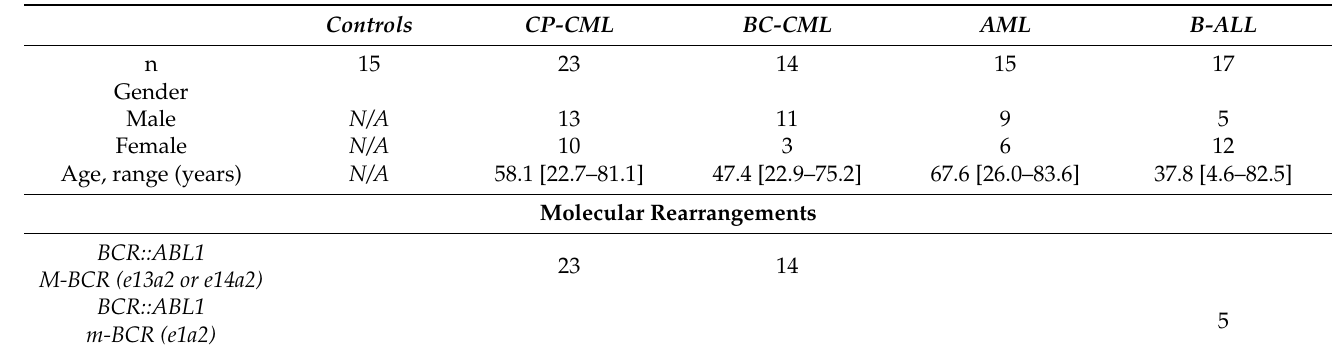
Table 3. Characteristics of the different cohorts tested for CD25 mRNA expression. CP-CML, chronic phase CML; BC-CML, Blast crisis CML; AML, acute myeloid leukemia; B-ALL, B-cell lym- phoblastic leukemia; N/A, anonymized healthy